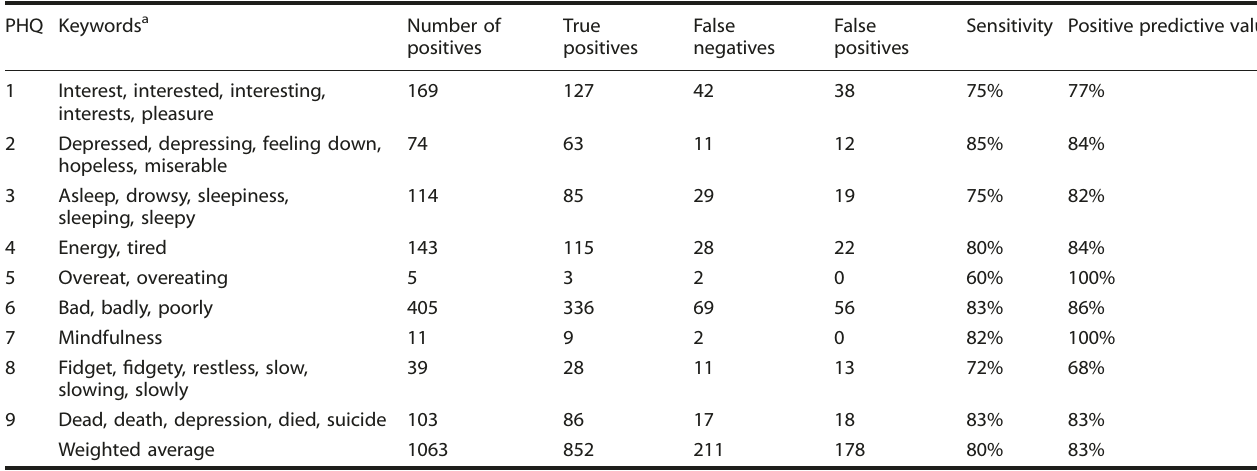
Table 3. Performance on clinically-relevant utterances by